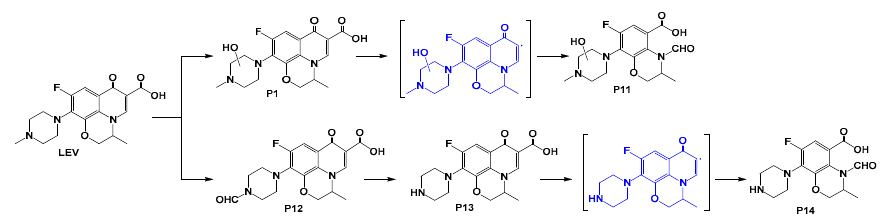
Figure 9. Proposed pathways (ii) of the degradation of LEV.